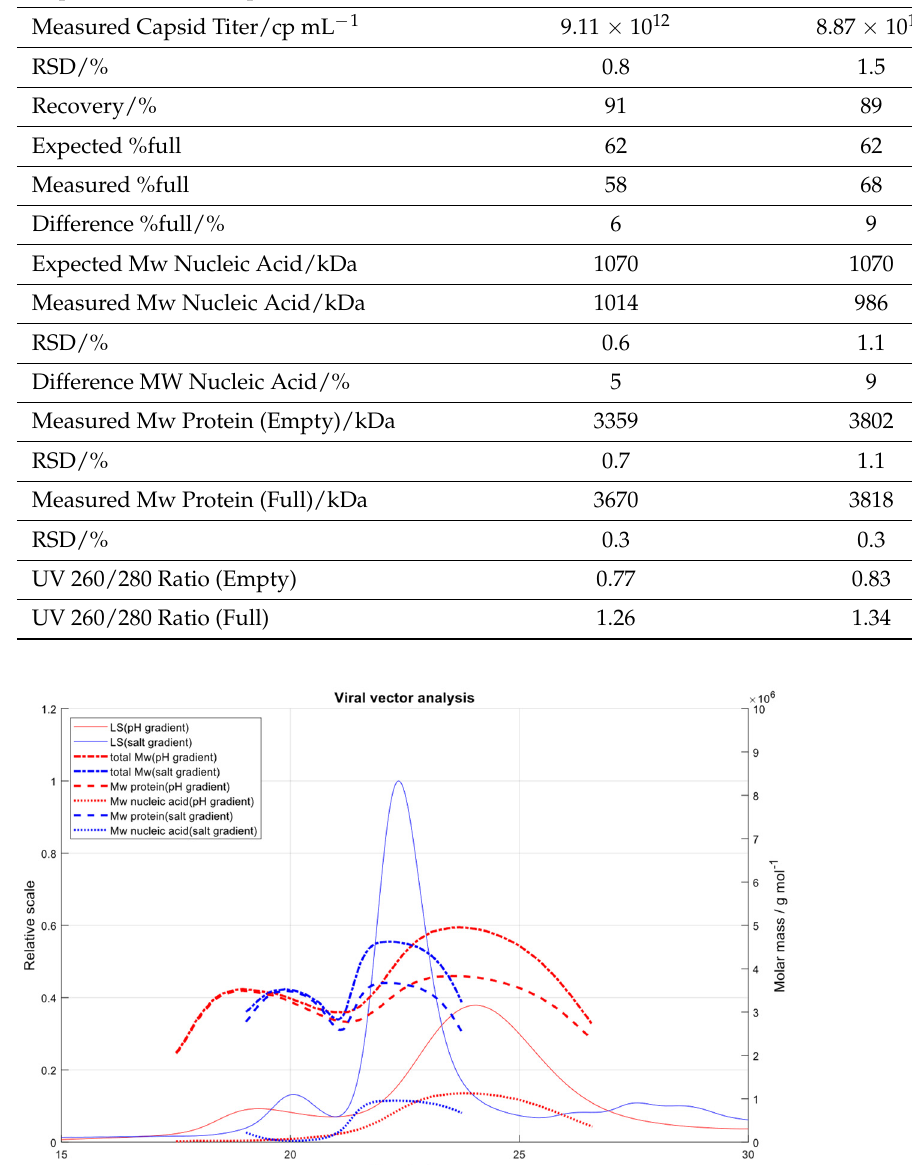
Figure 6. Evaluation of the method performance of the developed IEC-MALS assay using five dif- ferent anion-exchange columns. The strong AEX columns ProSwift SAX-1S (blue), UNO Q Polishing (purple) and CIMac AAV full/empty (green) and the weak AEX columns ProSwift WAX-1S (orange) and CIMac PrimaS (yellow). Dashed lines (1)–(6) represent (a) the expected F/E ratio, (b) the absolute molar mass of the protein, the absolute molar mass of the encapsidated ssDNA, (c) the hydrody- namic radius, the radius of gyration of empty AAV capsids and the radius of gyration of filled AAV particles, respectively.